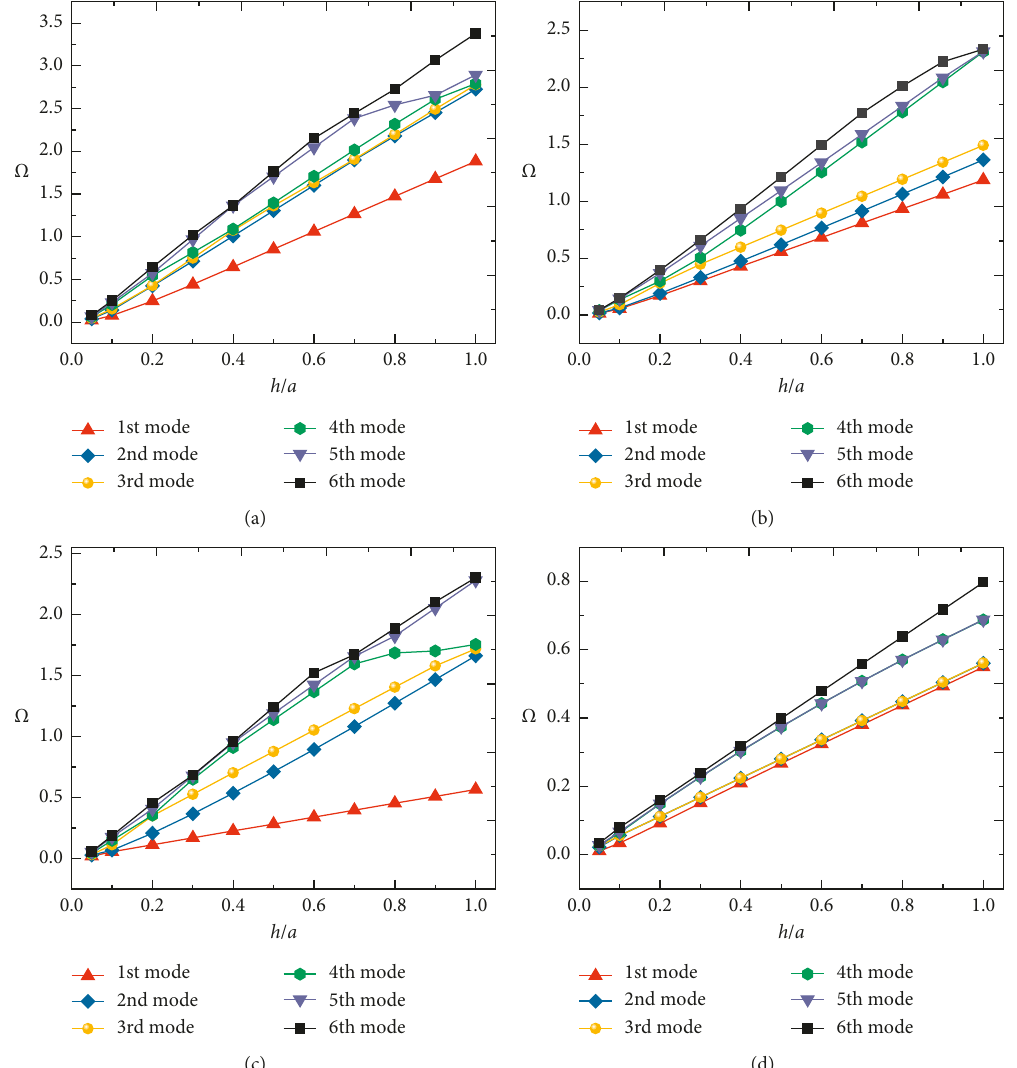
Figure 11: Variations of nondimensional frequency parameter Ω of orthotropic rectangular plates with respect to different thickness ratios h / a : (a) CCCC; (b) CFCF; (c) E2E2E2E2; (d)